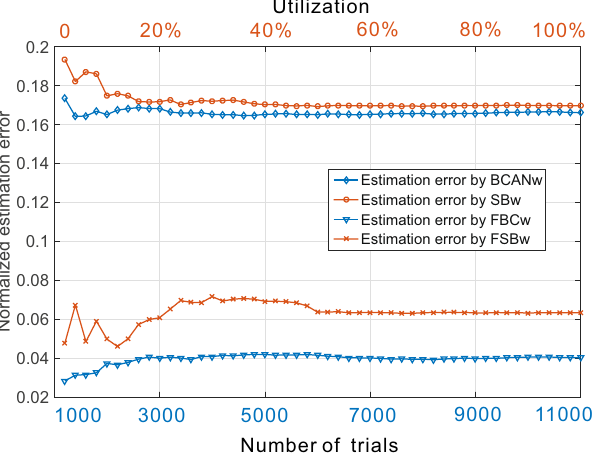
Figure 7. Normalized estimation errors of dominant fractal dimension of G 5 ( b = 3, s = 1/2) under different (i) numbers of the repeated trials for box-covering-based methods (BCANw and FBCw) and (ii) utilization of nodes as sandbox center for sandbox-based methods (SBw and FSBw). Averaging the estimations over an increasing number of box-covering trials or nodes used as sandbox centers brings trivial improvement to the intrinsically biased estimation of BCANw and SBw. The proposed FBCw and FSBw provide better accuracy by addressing the finite resolution and the skewness of the link weight distribution of the weighted complex